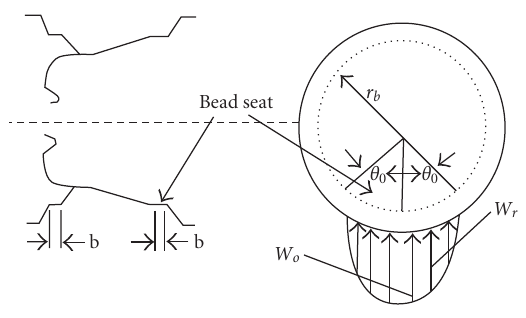
Figure 3: A schematic showing the radial loading